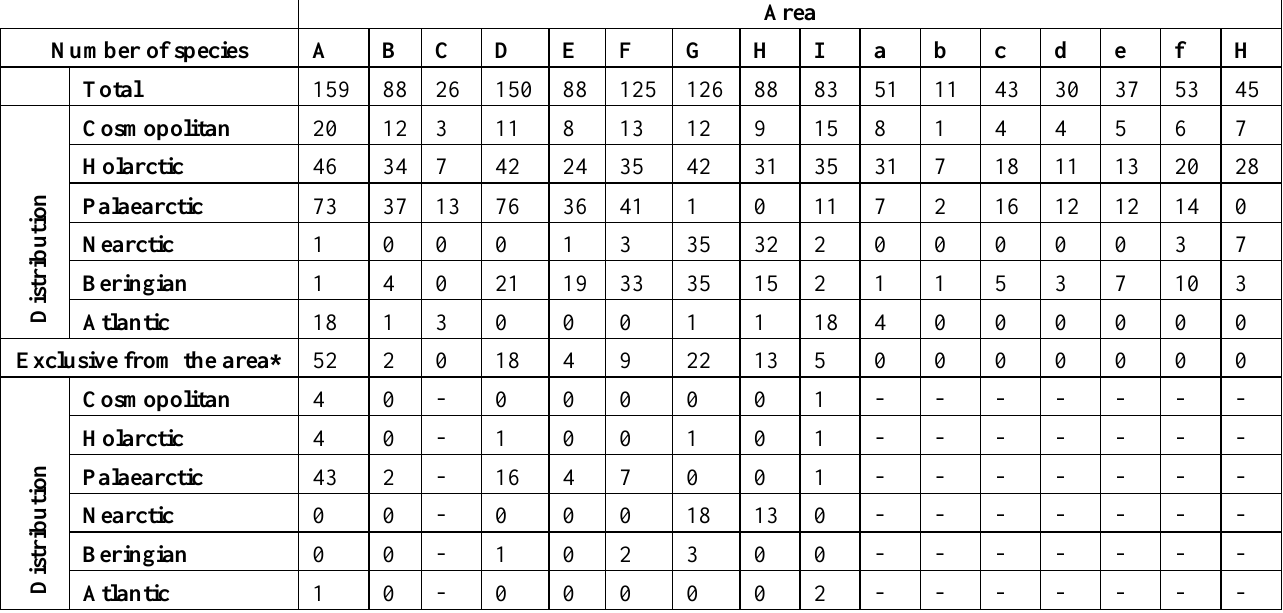
Table 1 Number of species described from each area and the number of species showing each main type of distribution. Dubious records, as defined in the text, are not